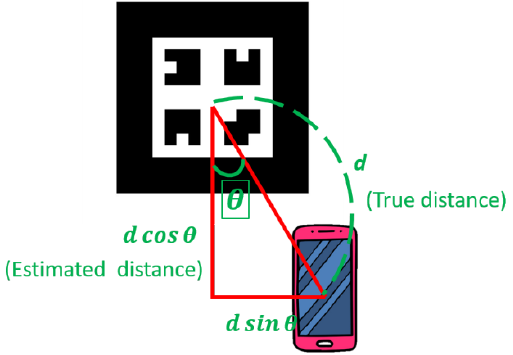
Figure5. The error of the distance estimation